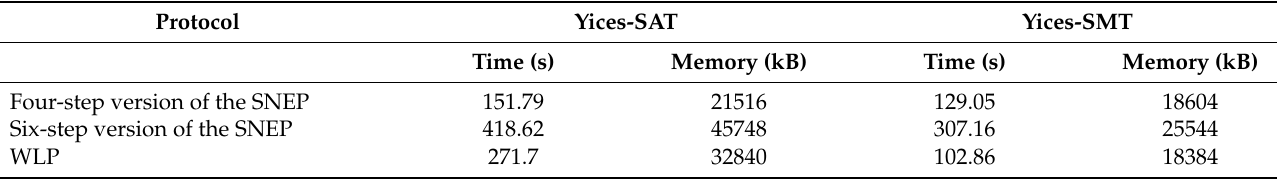
Table 3. Experimental results for SAT- and SMT-based methods and protocols (reachability of the last location in each automaton). Protocol